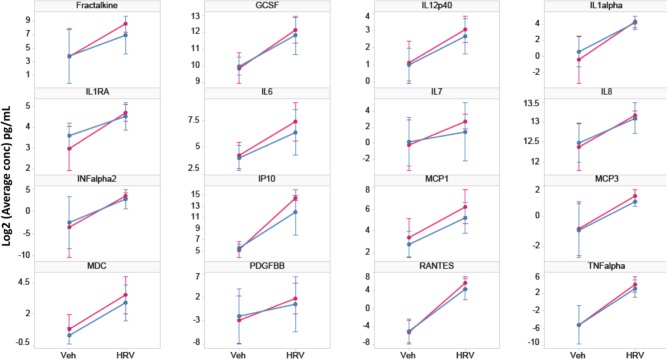
Expression of secreted cytokines/chemokines in culture medium.16/42 cytokines tested had robust expression levels and were significantly up-regulated at 24 hr after RV-A16 infection across 12 donors (p value<0.05). Differences were not significant between asthma and non-asthma groups (p>0.05). Red lines represent asthma samples, blue lines represent non-asthma samples. Each line represents the mean and standard deviation of log2 concentration of each cytokine/chemokine.